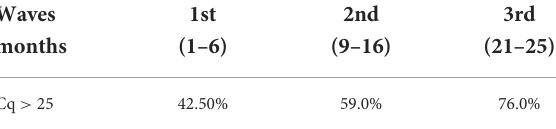
TABLE 4 Percentage of Cq-values > 25 concerning the total Cq-values in each wave of contagion (1st, 2nd, and 3rd) and months of the pandemic (1–6; 9–16; 21–25) in